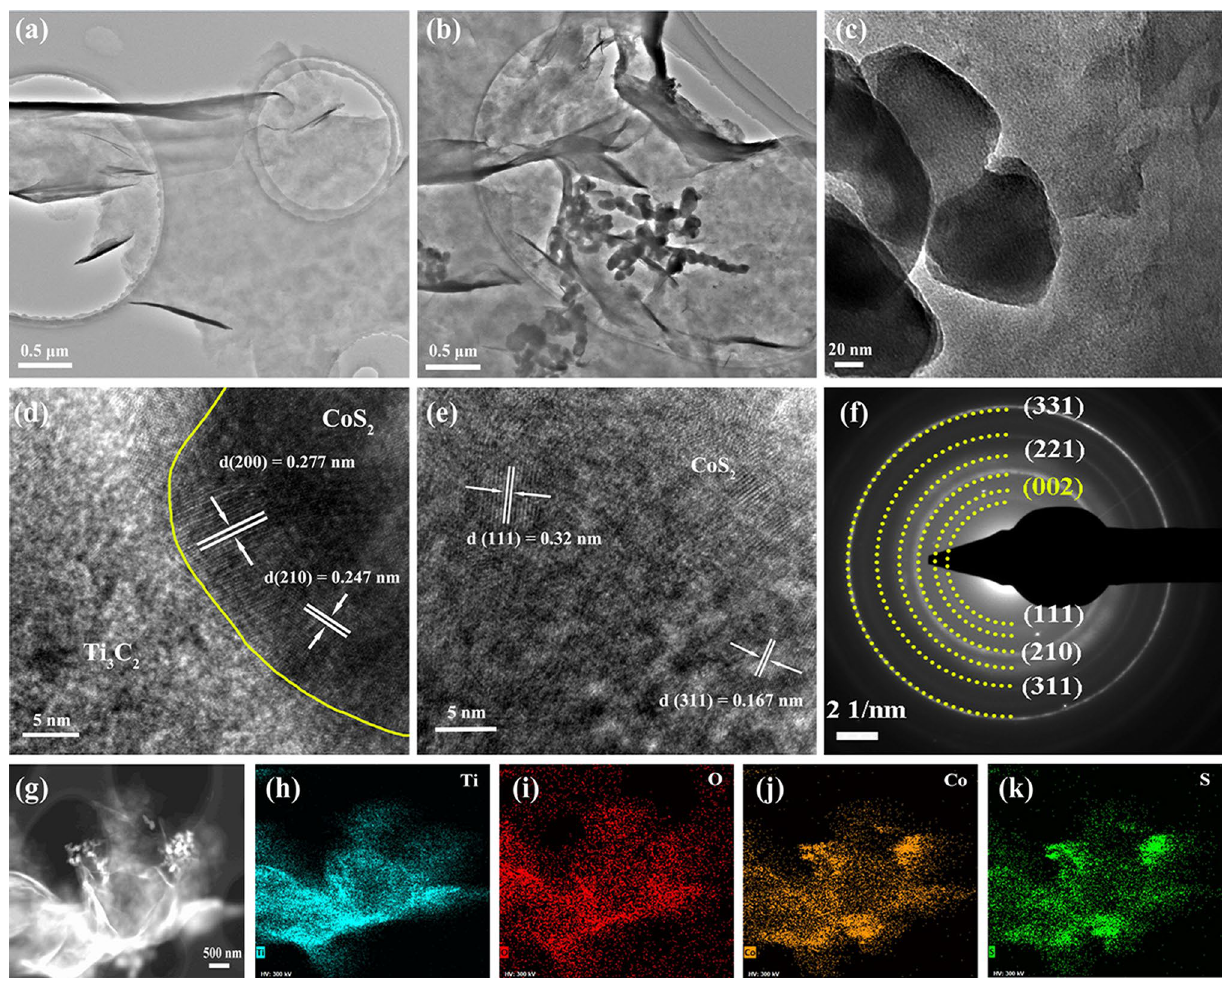
Fig. 1 a TEM image of MX. b , c TEM image, d , e HRTEM image, f SAED patterns, and g – k HAADF-STEM image and the corresponding EDS elemental mapping of MX@CoS